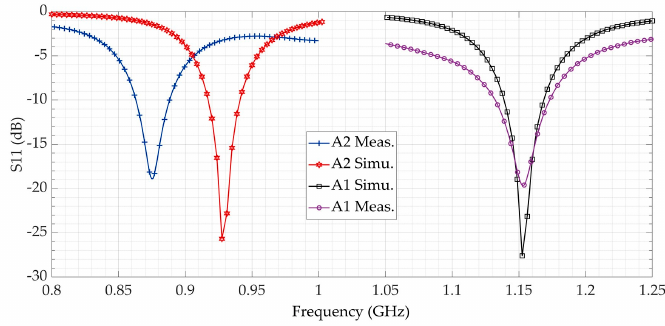
Figure 10. Measured and simulated reflection coefficient of the A1 and A2 antennas.